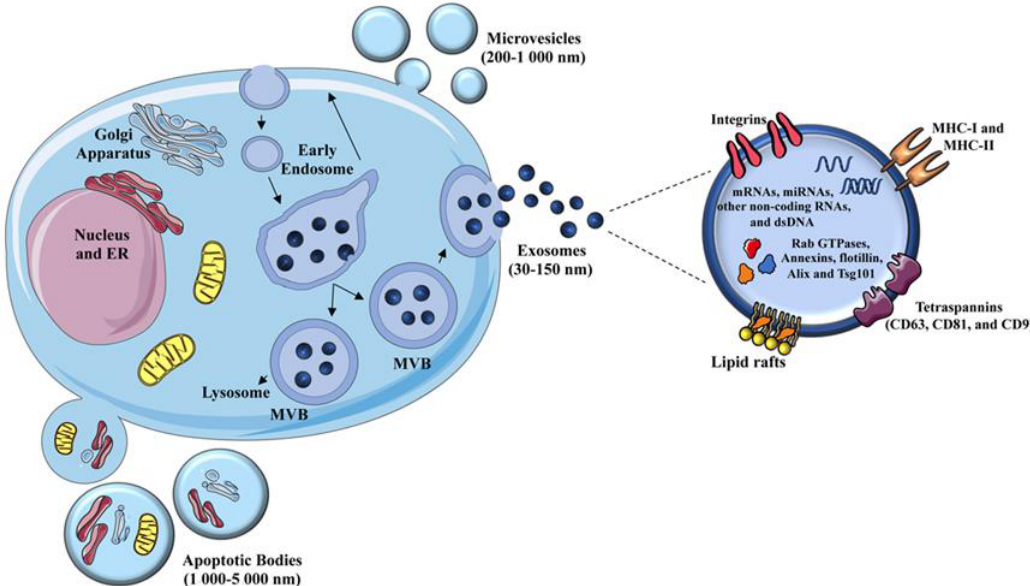
Figure 1. Biogenesis and composition of extracellular vesicles. Extracellular vesicles (EVs) include microvesicles, exosomes, and apoptotic bodies. Microvesicles are shed from the plasma membrane through protrusion or budding; exosomes are nanovesicles released from specific endosomal compartments, namely Multivesicular Bodies (MVB), upon their fusion with the plasma membrane; apoptotic bodies are generated by blebbing of the plasma membrane from cells undergoing apoptosis. Exosomes have been studied most widely, and their components, including lipids, proteins, and nucleic acids, are depicted. Most of them are shared with microvesicles. Modified from